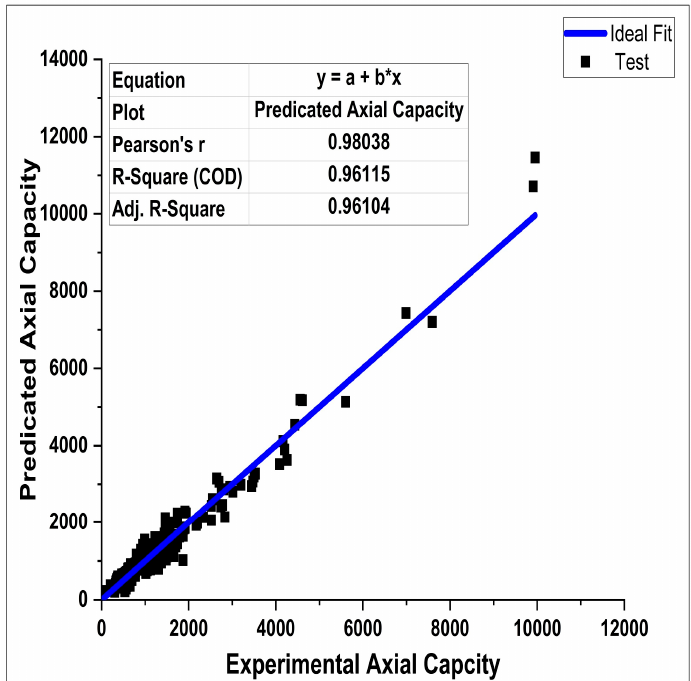
Figure 5. Predicted axial capacity vs. experimental results using the GEP model. Table 4. GEP model execution results.